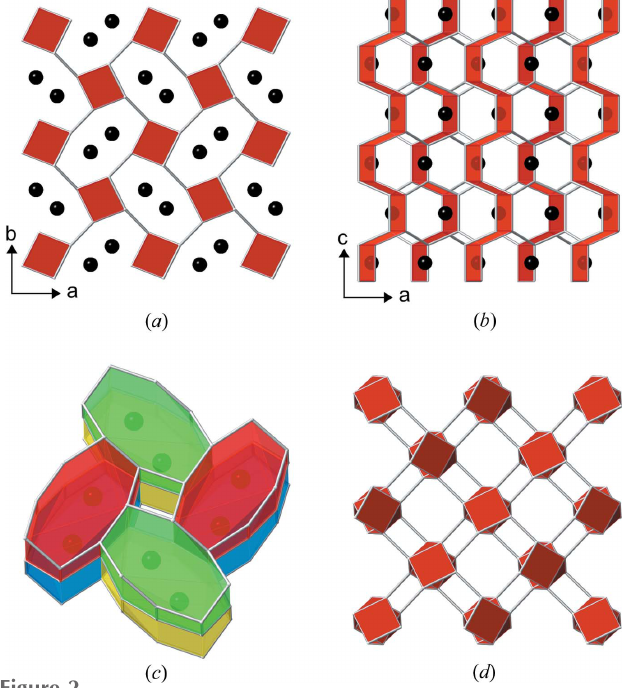
Figure 2 Framework topology of K-paracelsian and a related feldspar represented by connected T sites. ( a ) and ( b ) topology of K-paracelsian. Red planes are used to emphasize the double-crankshaft chains and the black spheres represent potassium positions. The structure is shown in projection parallel and perpendicular to the double-crankshaft chains, respectively. ( c ) K-paracelsian cages occupied by potassium atoms. All cages are equivalent by space group symmetry ( Pnam ). Colours have been added to emphasize individual cages. ( d ) Framework topology of the feldspar mineral microcline in projection parallel to the twisted double-crankshaft